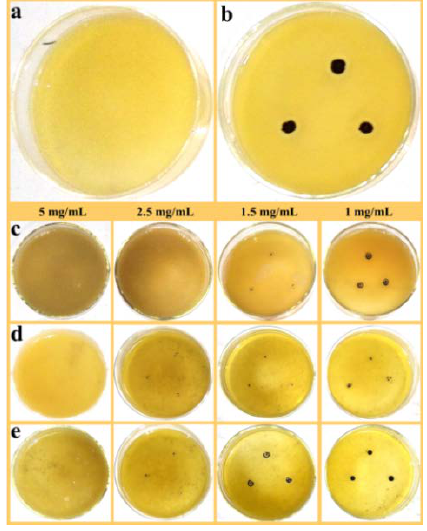
Figure 7. ( a ) Blank control, ( b ) positive control of S. aureus and S. aureus treated using ( c ) ZnO/PAL, ( d ) ZnO/PAL-1 and ( e ) ZnO/PAL-2. Table 2. The minimum inhibitory concentration (MIC) values of PAL, ZnO/PAL, ZnO/PAL-1 and ZnO/PAL-2 against E. coli and S. aureus .